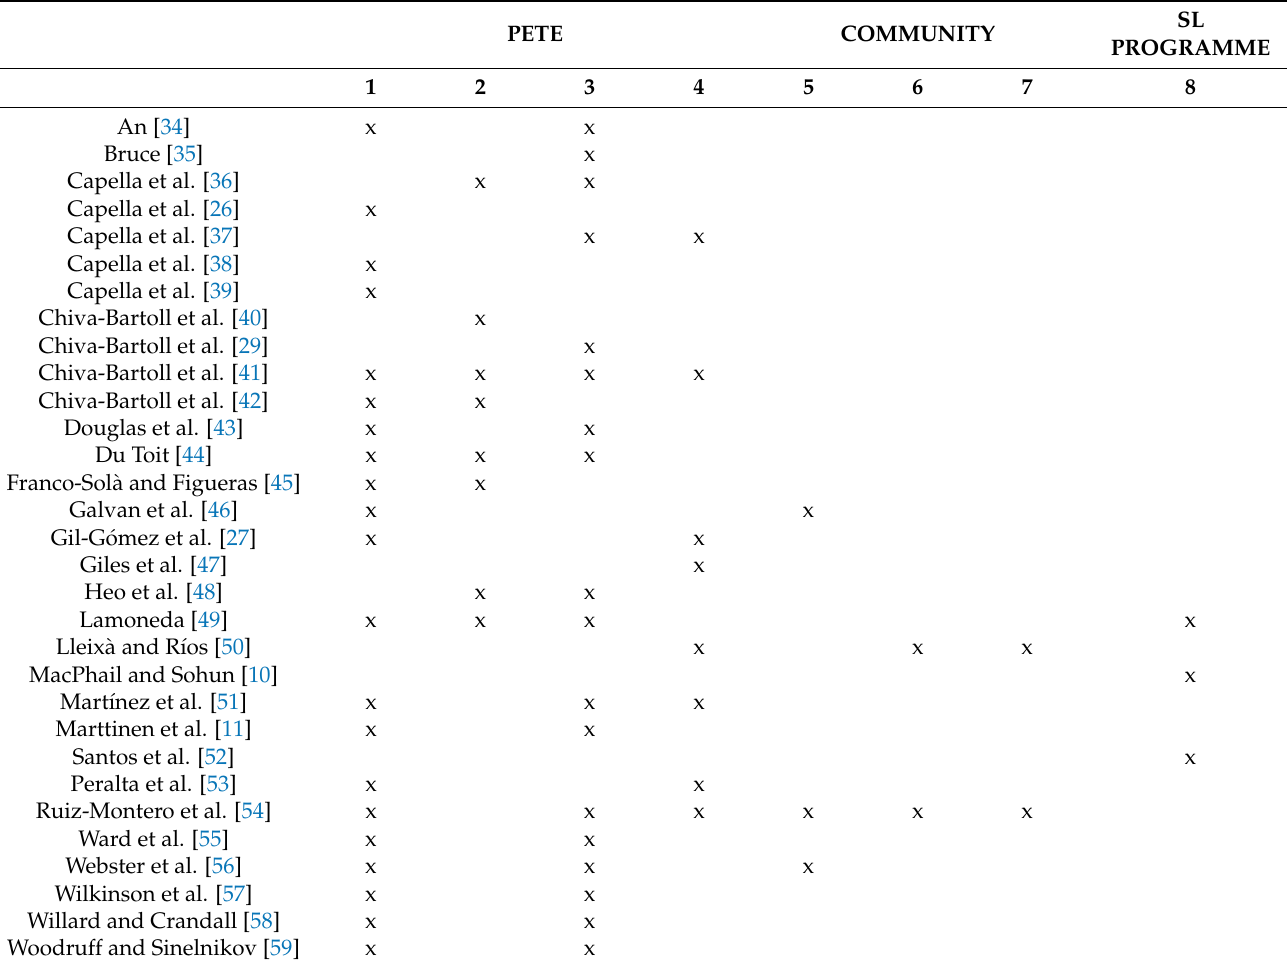
Table 2. Objectives of the